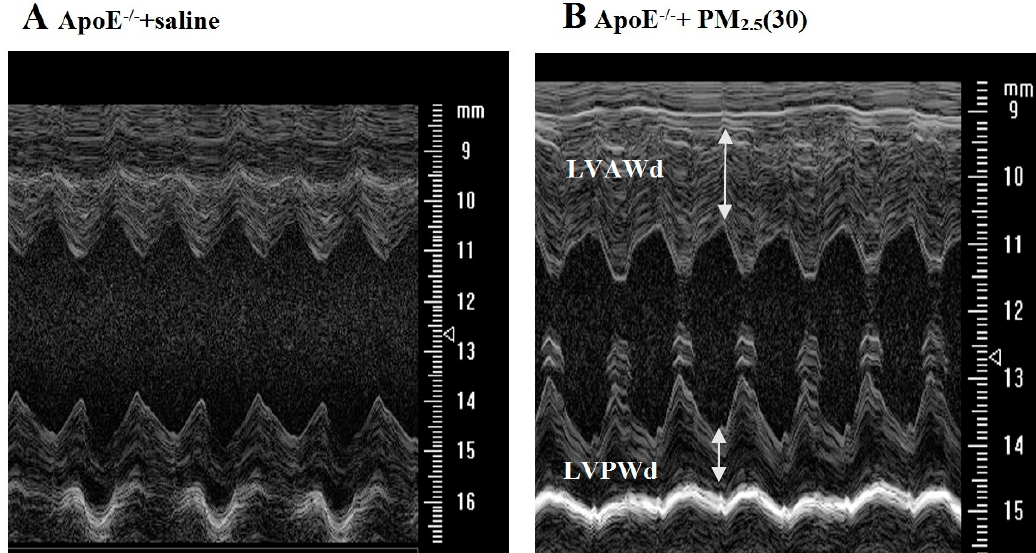
Figure 3. Echocardiography images of ApoE − / − mice. ( A ) Represent control group, normal structure;